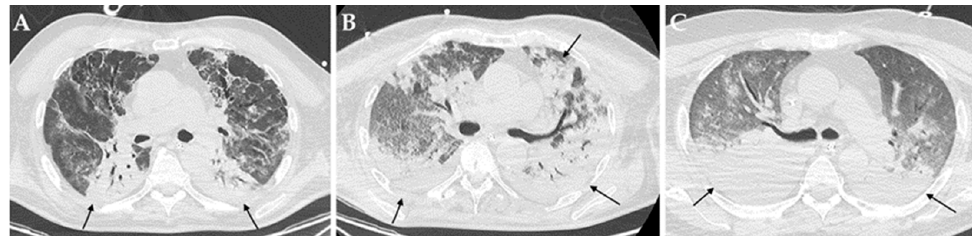
Figure 2. Axial HRCT images of different patients ( A – C ) with COVID-19 ARDS admitted to ICU showing bilateral consolidations (black arrows). In particular, all these patients developed a pulmonary superinfection by Klebsiella pneumoniae ( A ), Pseudomonas aeruginosa plus Acinetobacter baumannii ( B ) and Staphylococcus aureus plus Candida albicans . Table 3. Comparison of imaging findings of patients with and without at least one pulmonary bacte- rial or fungal co-infection/superinfection and with and without invasive pulmonary